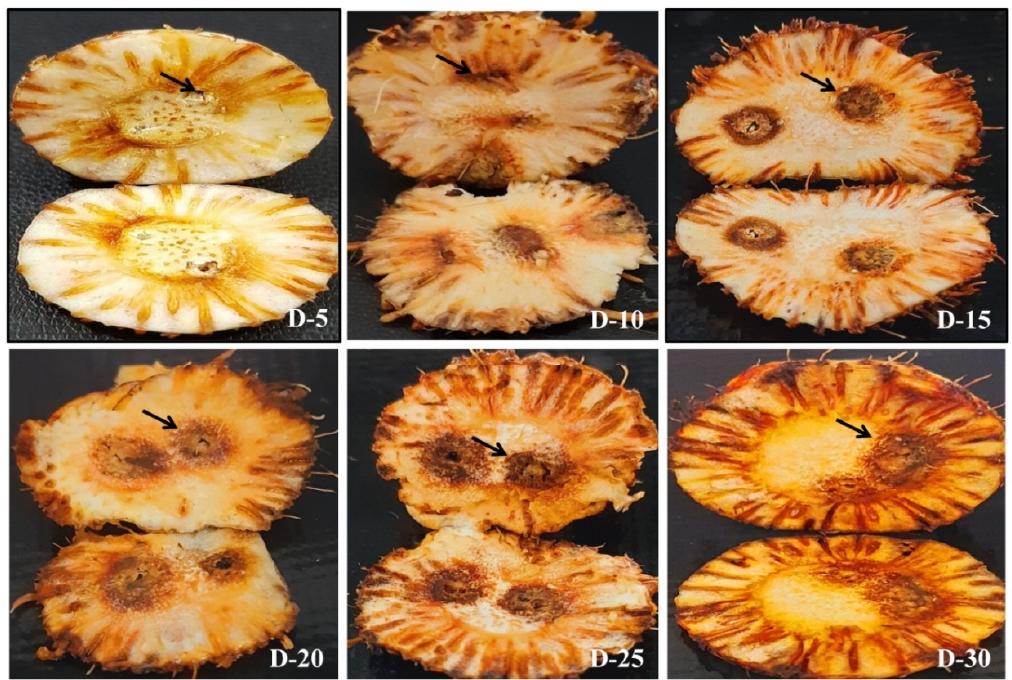
Figure 5. Symptoms of corm rot in the corm basal plate of T3 (corm injury + Fox R1) treatment. D-5, D-10, D-15, D-20, D-25, D-30 represent days post inoculation. Arrows indicate the injury point from where infection spread all over the basal plate.